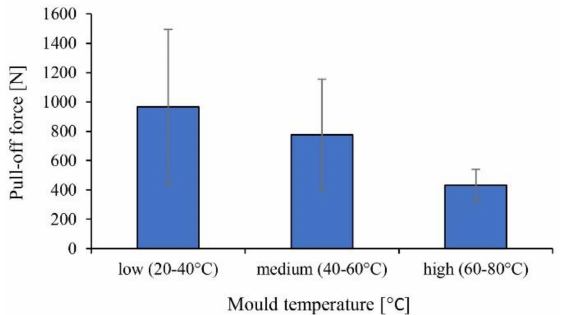
Figure 9. The pull-off force as a function of mold temperature (commercially available in situ PA6 plate (IS-A); holding pressure was 200 bar and holding time was 1 s).